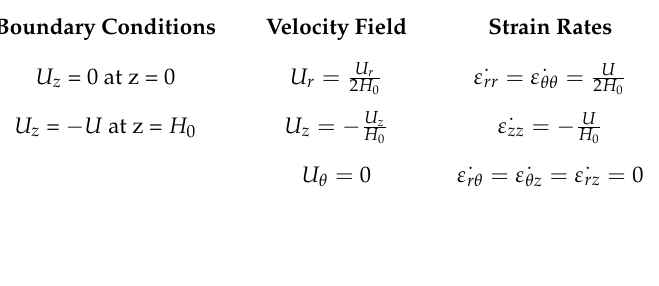
extreme short contact time under deformation. Because of this effect, the internal heat generated during the deforma- tion cannot escape-out quickly and decreases the strength of material. Also, the slender preforms exhibit lower inertia effects as compared to shorter ones, as they make contact with the die-container much later and the contact area is also